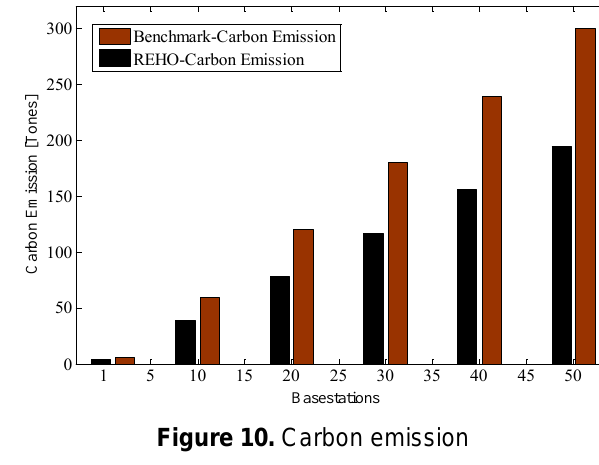
Figure 8. Radio link failure